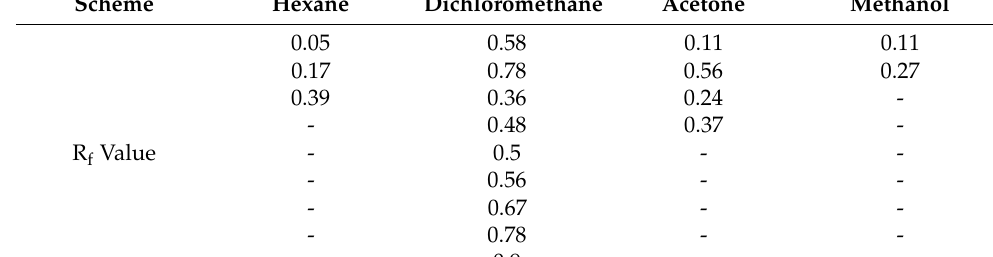
visualized under UV. The elliptical circles show the clear zone where bacterial growth has been inhibited. Table 2. R f values of active compounds from M. angustifolia representing A. baumannii growth inhibition. Scheme Hexane